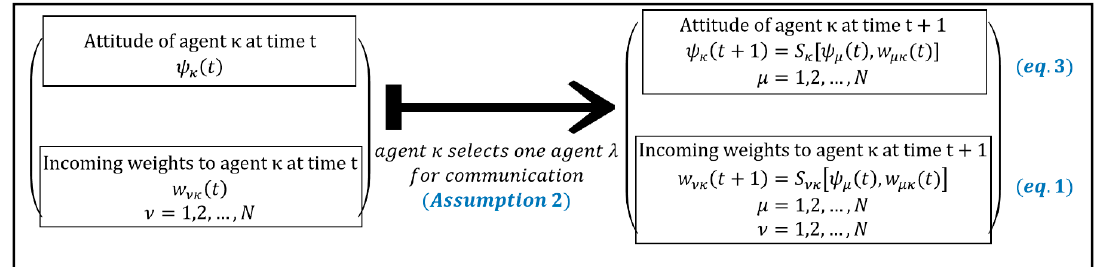
Figure 1. Local mechanism for interdependent co-evolution of weights and attitudes for each agent κ , κ = 1,2, ... , N , at each time t = 0,1,2, ... Co-evolution is interdependent because at each step, the change of attitudes depends on the value of the attitudes and the value of the weights, as well as the change of the weights depends on the value of the attitudes and the value of the weights. Both changes are simultaneous.